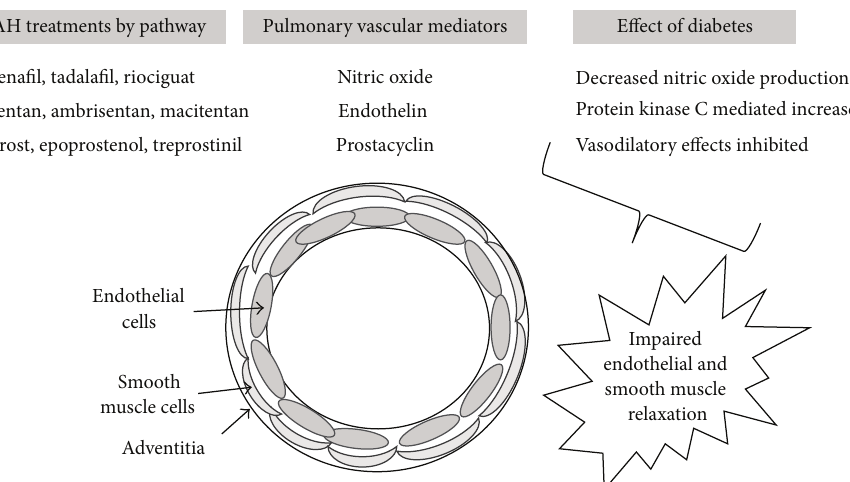
Figure 2: Role of diabetes mellitus in promoting vasoconstriction within the pulmonary arteriole and the potential impact on the efficacy of medications commonly used to treat pulmonary